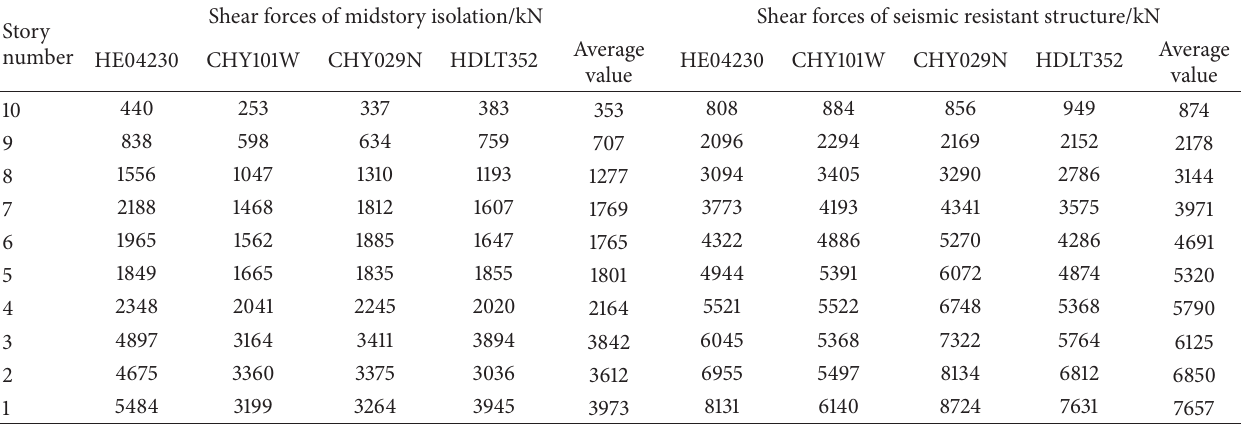
Table 3: Comparison of peak shear forces of seismic resistant structure and midstory isolation under different earthquake waves.